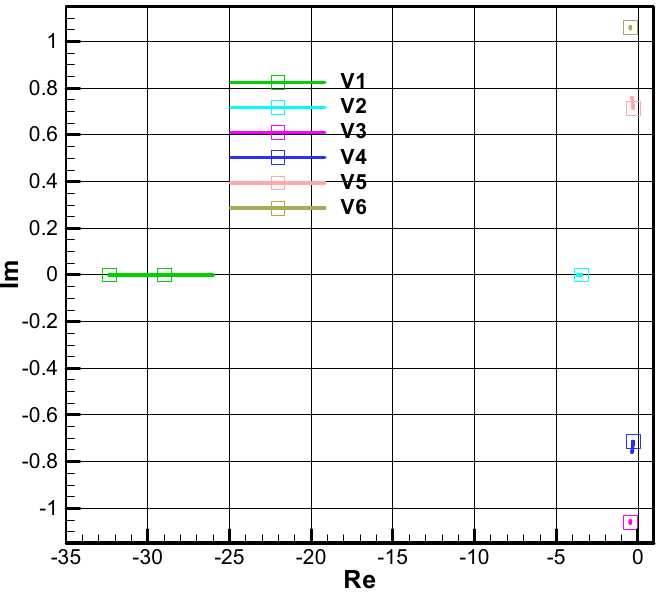
Figure 12. Eigenvalues of the matrix A − BK for lateral motion.